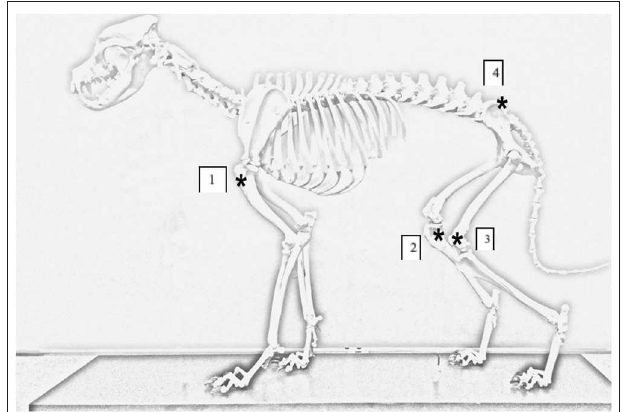
FIGURE 1 | Canine skeleton demonstrating anatomical locations for IO catheter placement. Asterick annotates the IO catheter insertion sites on the canine cadaver. (1) Placement site for proximal humerus. (2) Placement site for proximal medial tibia. (3) Placement site for distal lateral femur. (4) Placement site for ileal wing.